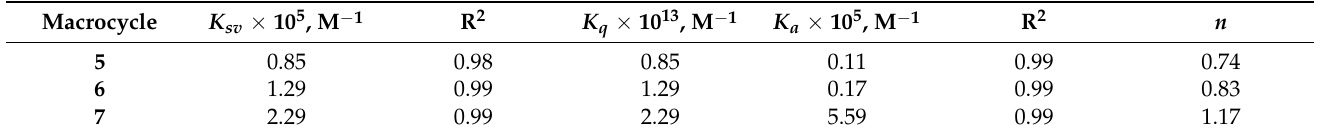
Table 2. Binding parameters of 5 – 7 with CT-DNA evaluated for the EthBr displacement experiment.